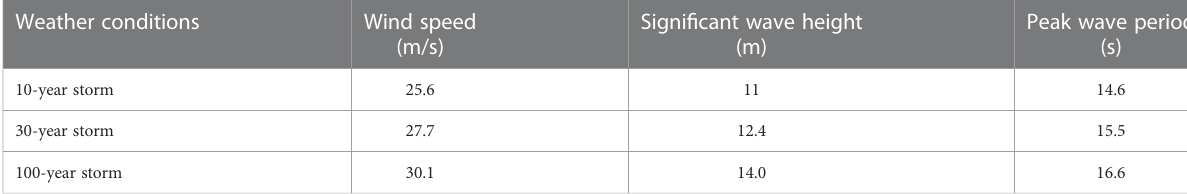
TABLE 3 Storm conditions: Wave height and period de fi nes a modi fi ed Pierson – Moskowitz spectrum. Weather conditions